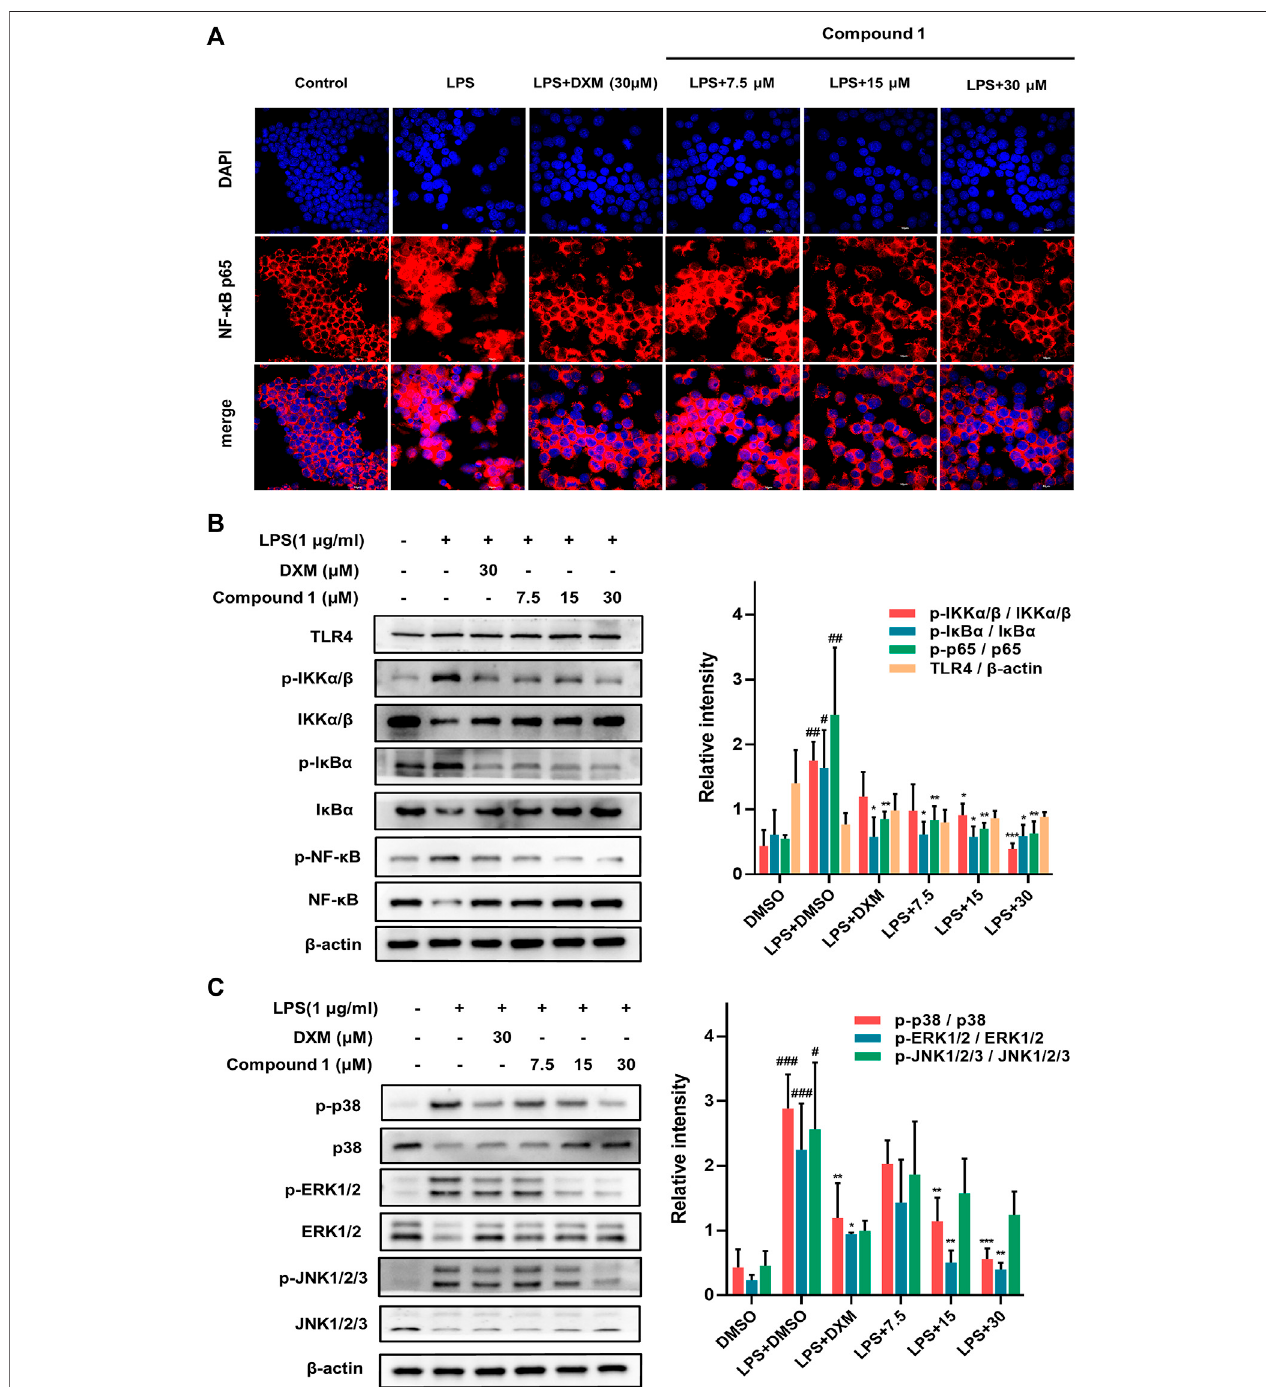
FIGURE 6 | (A) The protective effect of 1 in LPS-treated RAW264.7 macrophages. Representative red fl uorescence images indicating intracellular p65 stained by Cy3. RAW264.7 macrophages were pretreated with 1 for 1 h and then exposed to 1 μ g/ml LPS for 2 h (B,C) RAW264.7 macrophages were pretreated with 1 for 1 h and exposedto1 μ g/mlLPS.ExpressionofIKK,p-IKK(LPSstimulated1 h),NF- κ B/p65,p-NF- κ B/p65(LPSstimulated 2 h),I κ B α and p-I κ B α (LPSstimulated2 h)inthe NF-kB pathway. Expressions of ERK, p-ERK (LPS stimulated 1 h), JNK, p-JNK (LPS stimulated 1 h), p38 and p-p38 (LPS stimulated 2 h) in the MAPK pathway. The levels of signaling pathway proteins were determined by Western blotting. Data are expressed as the mean ± SD. ### p < 0.001, compared with the normal control group. * p < 0.05, ** p < 0.01, and *** p < 0.001, compared with the LPS group.